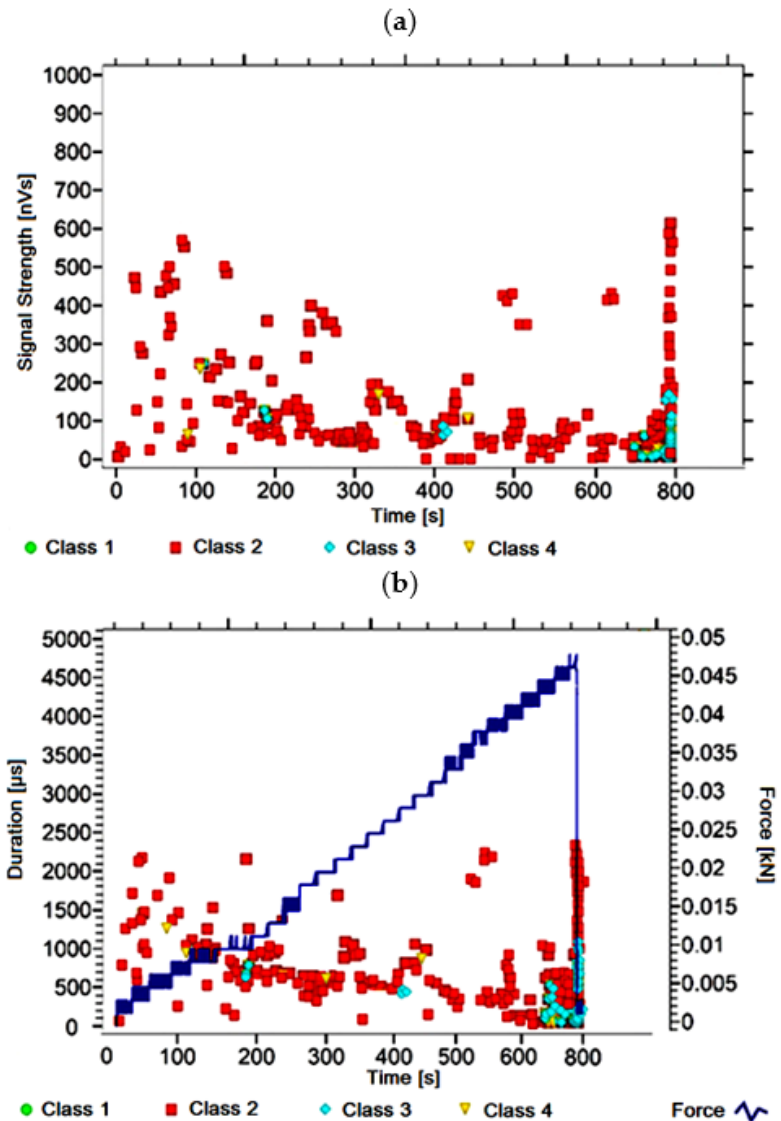
Figure 13. Graphs of acoustic emission signals for an exemplary sample of A12 series: ( a ) signal strength over time; ( b ) distribution of the duration of the signals over time with the force increment curve.